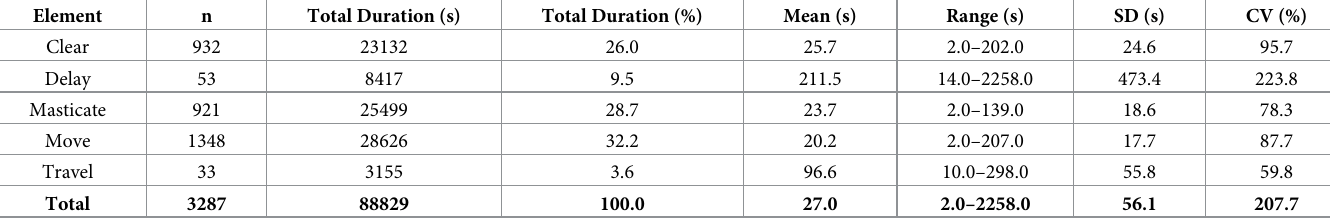
Table 2. Work sampling summary statistics for mastication equipment by element for the full field sampling